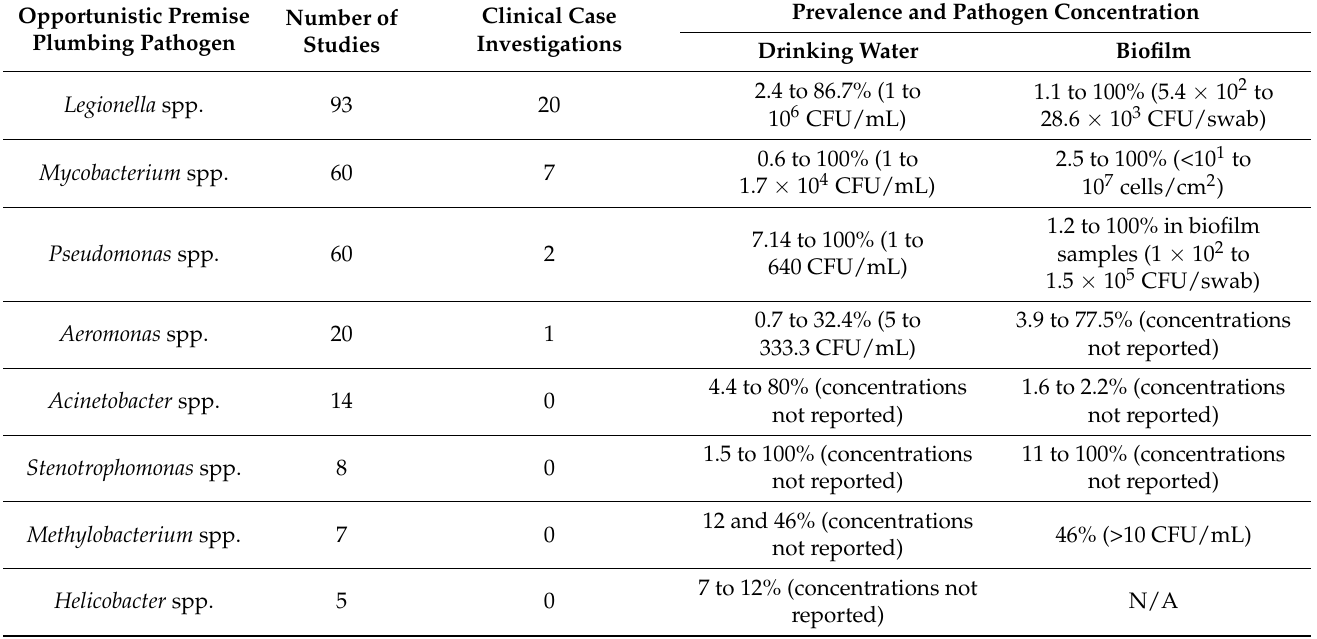
Table 2. Summary of reported prevalence and concentrations of opportunistic premise plumbing pathogens detected in residential drinking water